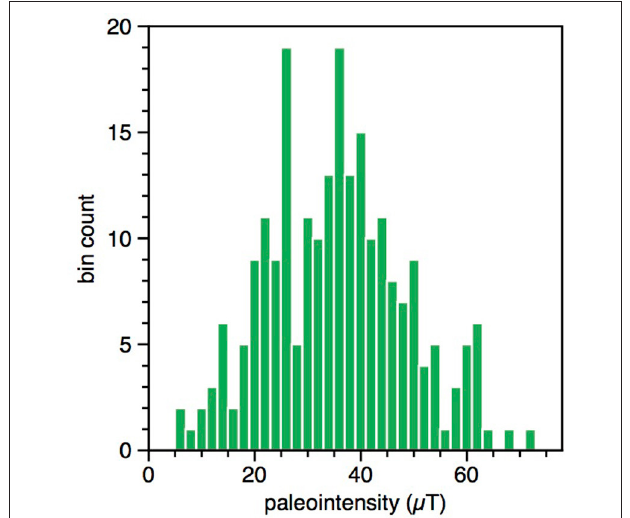
FIGURE 3 | Histogram of bin count vs. intensity for the palaeointensity data from the PINT palaeointensity database ( Biggin et al., 2009, http://earth.liv.ac. uk/pint), for the 10–20 ◦ bin. The palaeointensity data were selected from the PINT database from sites ≤ 5Ma, for which there were at least three intensity estimates. The northern and southern hemisphere data are combined. The data is not distinguishable from a Gaussian distribution at 95%